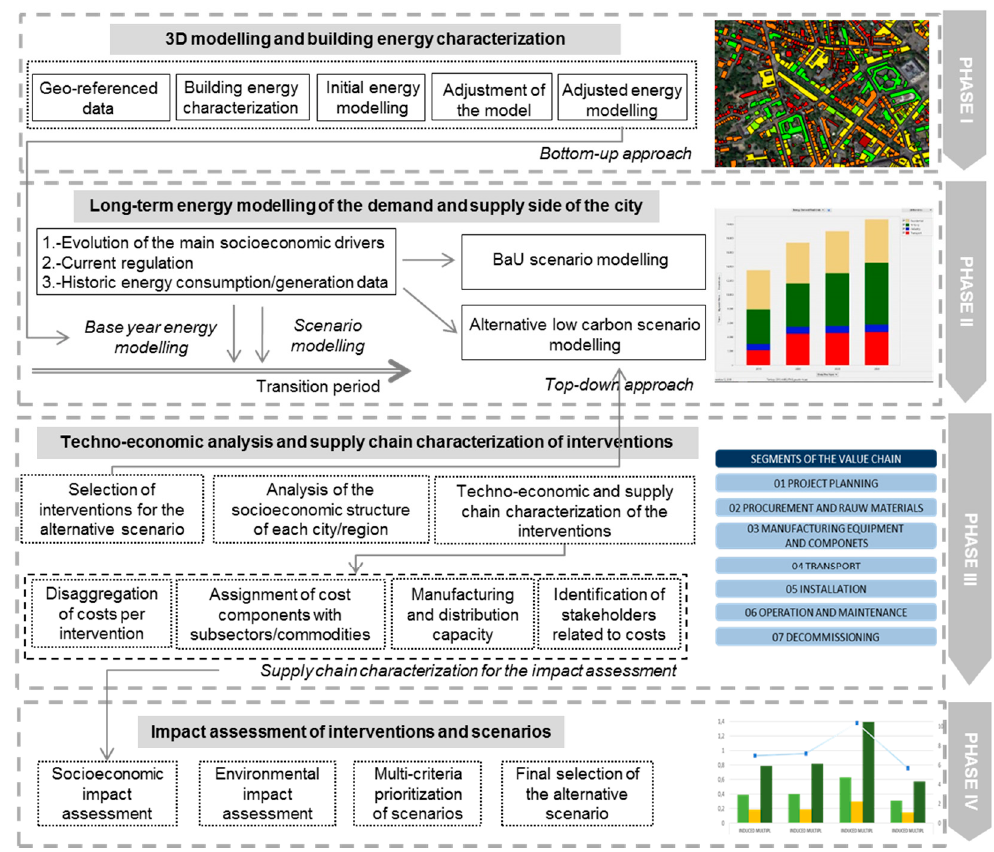
Figure 1. Main phases of the long-term urban energy modelling